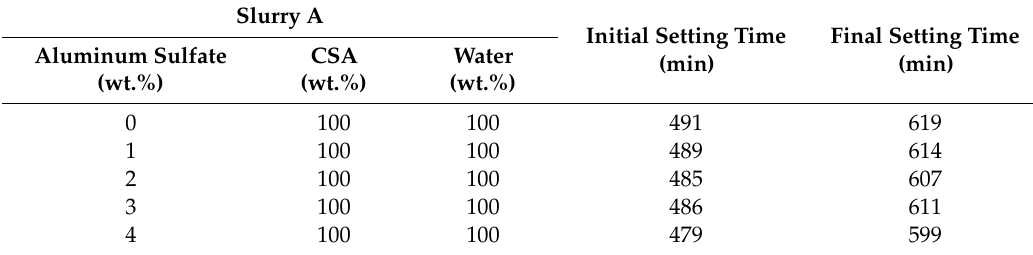
Table 5. Setting time of the slurry A with di ff erent content of aluminum